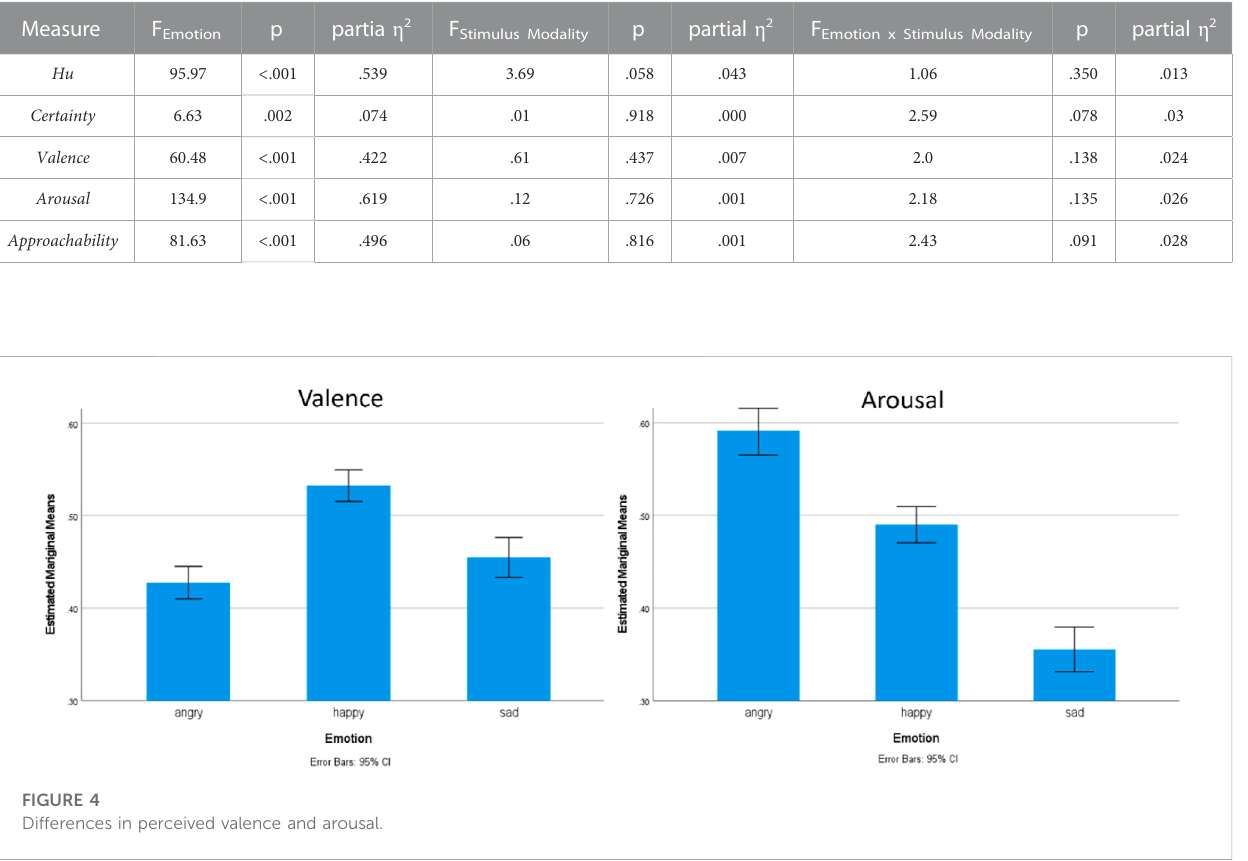
TABLE 4 Results from repeated measurement ANOVA with emotion as within-subject factor and stimulus modality as between-subject factor. Measure F Emotion p partia η 2